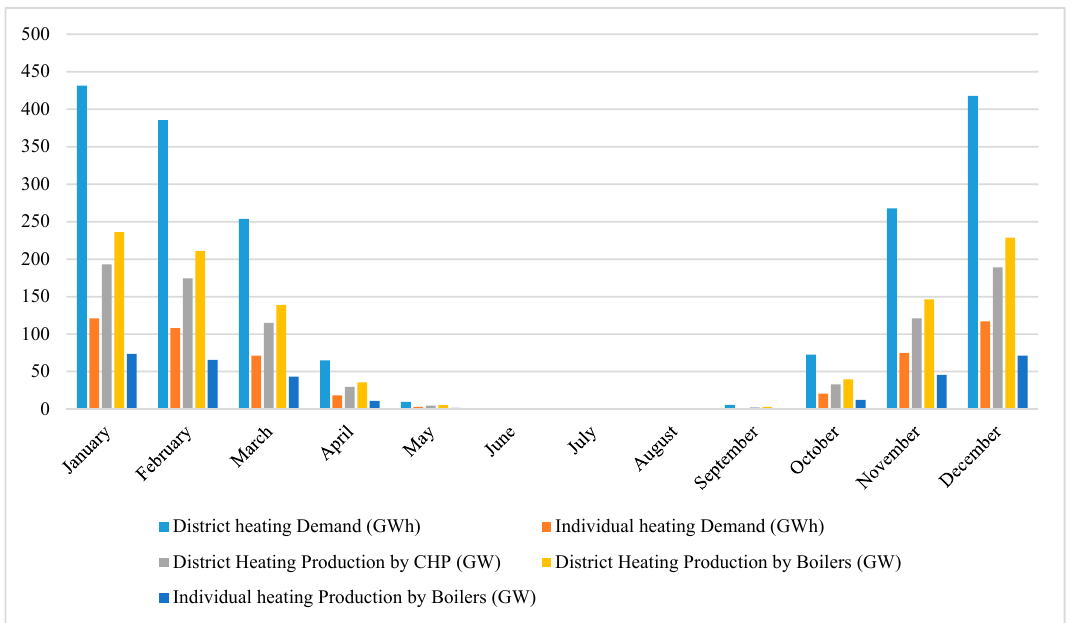
Figure 4. District and individual heating consumption and production by CHP and boilers.